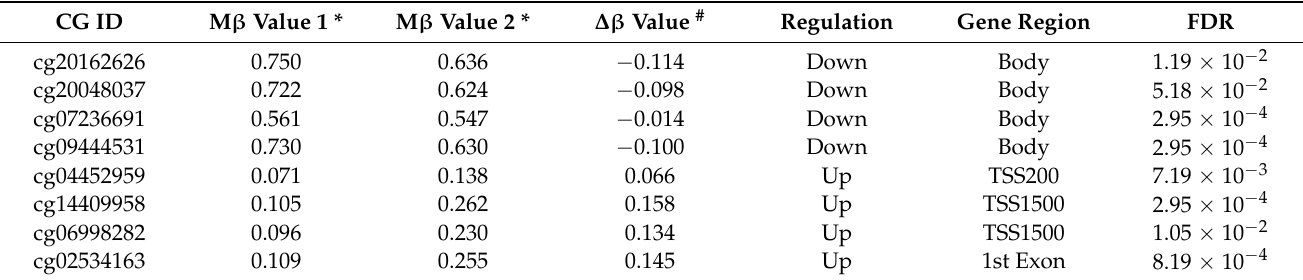
Table 7. Differential methylation and expression analysis of ENPP2 between normal lung and LC tumors from TCGA cases. CG ID M β Value 1 * M β Value 2 * ∆ β Value